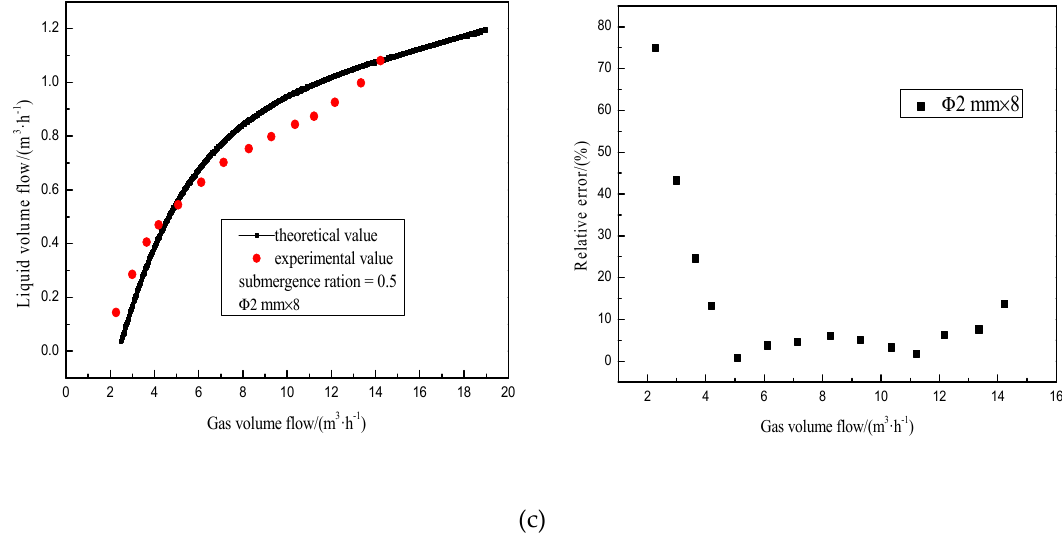
Figure 13. Comparison of experimental values and theoretical values at submergence ratio of 0.5 ( a ) Intake area of 100 mm 2 ; ( b ) intake area of 50 mm 2 ; ( c ) intake area of 25 mm 2 .